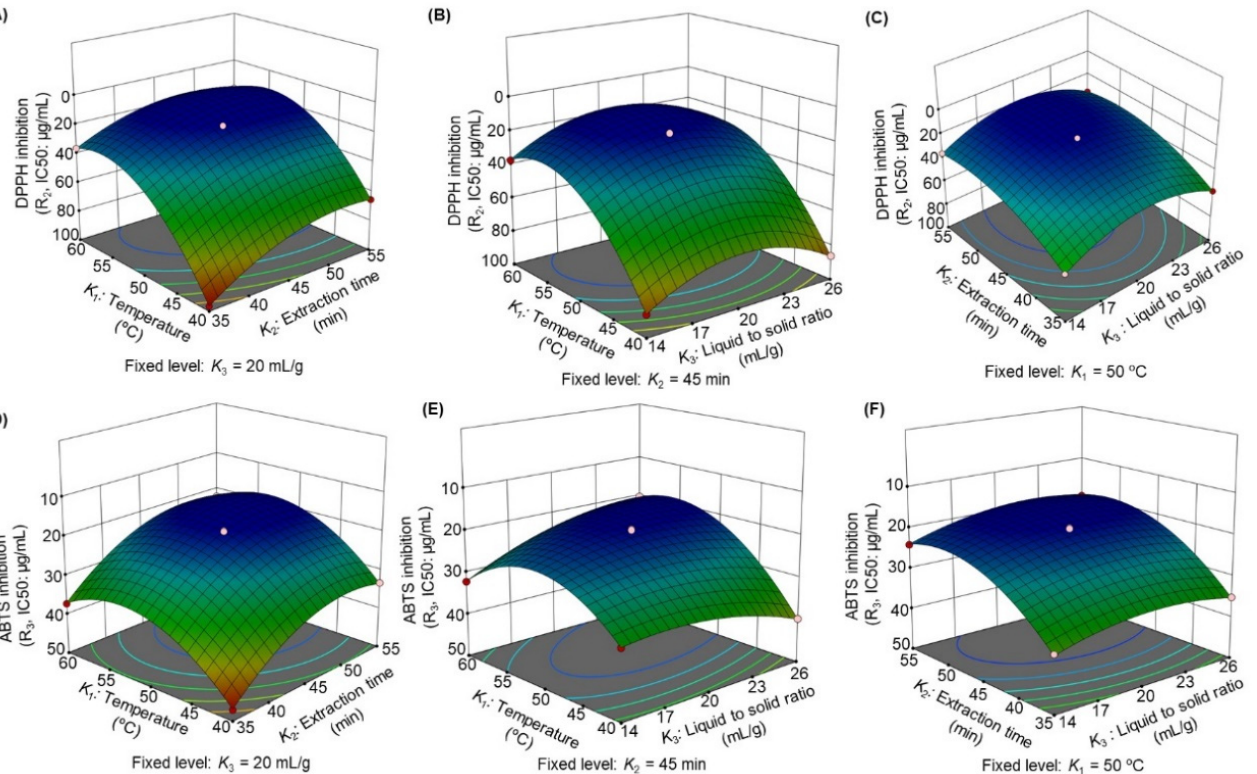
Figure 3. Response surface 3D plots showing the interaction effects of the UAE parameters on the DPPH ( R 2 ) and ABTS ( R 3 ) activity. ( A ) 3-D response surface plots shows the effects of K 1 and K 2 interaction on DPPH inhibition (IC 50 ) at constant K 3 (20 mL/g); ( B ) 3-D response surface plots shows the effects of K 1 and K 3 interaction on DPPH inhibition (IC 50 ) at constant K 2 (45 min); ( C ) 3-D response surface plots shows the effects of K 2 and K 3 interaction on DPPH inhibition (IC 50 ) at constant K 1 (50 ◦ C); ( D ) 3-D response surface plots shows the effects of K 1 and K 2 interaction on ABTS inhibition (IC 50 ) at constant K 3 (20 mL/g); ( E ) 3-D response surface plots shows the effects of K 1 and K 3 interaction on ABTS inhibition (IC 50 ) at constant K 2 (45 min); ( F ) 3-D response surface plots shows the effects of K 2 and K 3 interaction on ABTS inhibition (IC 50 ) at constant K 1 (50 ◦ C). The anticancer activity of the P. schimperi aerial part methanol extract was evaluated using the human liver cancer cell line (HepG2) and breast cancer cell line (MCF-7). The linear effects of K 1, K 2 , K 3 exhibited ( p < 0.001) a negative impact on the inhibition of the growth of HepG2 and MCF-7 cells with a high F-value for K 1 [(206.53 for HepG2 and 337.49 for MCF-7 cells inhibition)]. Similarly, the quadratic effects of K 1, K 2 , K 3 exhibited highly significant ( p < 0.0001) positive effects on the inhibition of HepG2 and MCF-7 cell growth. The F-values of the quadratic effects ( K 12 , K 22 , and K 32 ) were found to be 188.4, 14.61, and 22.58, respectively, for the HepG2 cells and 244.98, 54.27, and 66.20, respectively, for the MCF-7 cells. This indicates that the quadratic effect of the extraction temperature had the maximum impact on the inhibition of HepG2 and MCF-7 cells. From Figure 4A–E, it is evident that there was an insignificant impact ( p > 0.05) of interaction between K 1 K 2 , K 1 K 3 , and K 2 K 3 , on the growth inhibition of HepG2 and MCF-7 cells (Tables 4 and 5). This suggests that the inhibition of HepG2 and MCF-7 cell growth was chiefly affected quadratically by linear factors K 1 , K 2 , and K 3 and not by their interaction. Thus, the higher the extraction temperature, the better the growth inhibition of HepG2 and MCF-7 cells by the extract. This finding is in line with the findings of Aljawharah et al. (2022), which stated that P. schimperi extract was highly effective in controlling the growth of A375 cells (human melanoma cell line) [GI 50 (the average growth inhibition of 50%) = 19 µg/mL] by arresting the cell cycle at the S phase and activating caspase 3/7. The other species of Pulicaria genus (e.g., P. undulata and its phytoconstituents) also exhibited good